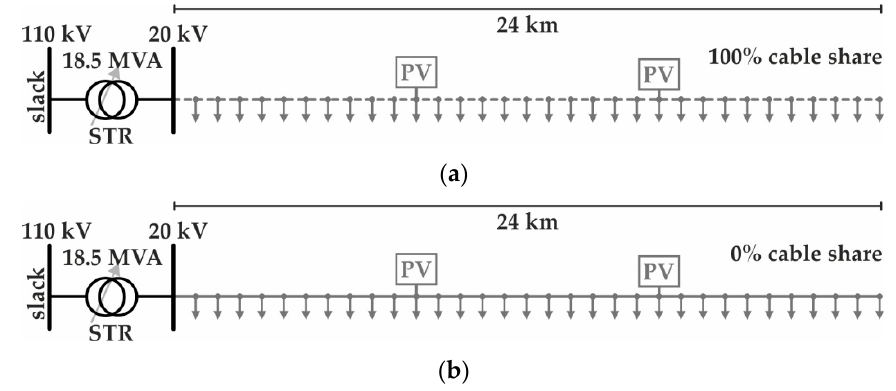
Figure 4. Simplified one-line diagrams of the MV_link-grid models with different conductor types: ( a ) cable; ( b ) overhead line.